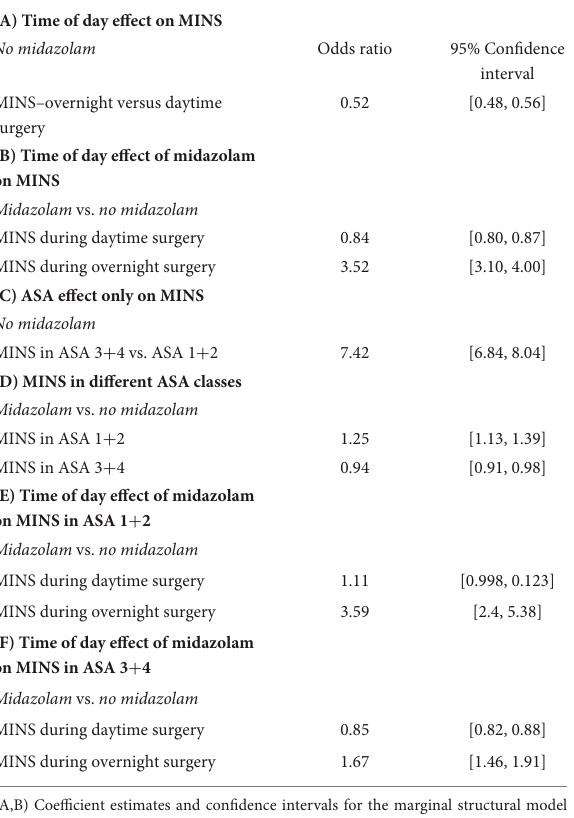
Coefficientestimatesandconfidenceintervalsforthemarginalstructuralmodelassessing the effect modification of the American Society of Anesthesiologists (ASA) class on midazolam administration. (E,F) Coefficient estimates and confidence intervals for the marginalstructuralmodelassessingtheeffectmodificationoftimeofdayonmidazolam administrationinASA1 + 2orASA3 + 4patients.